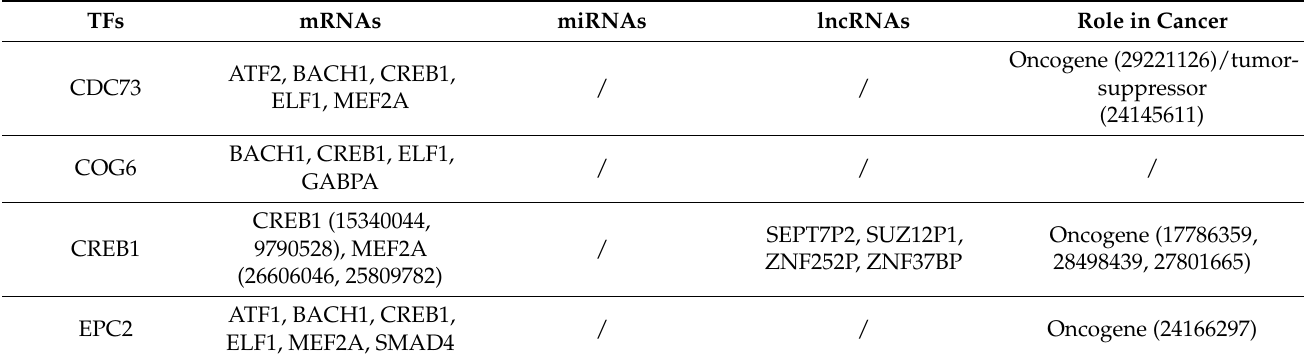
Table 2. The most frequent TFs regulating mRNA, miRNA and lncRNA coding genes in UM according to the most stringent parameters of